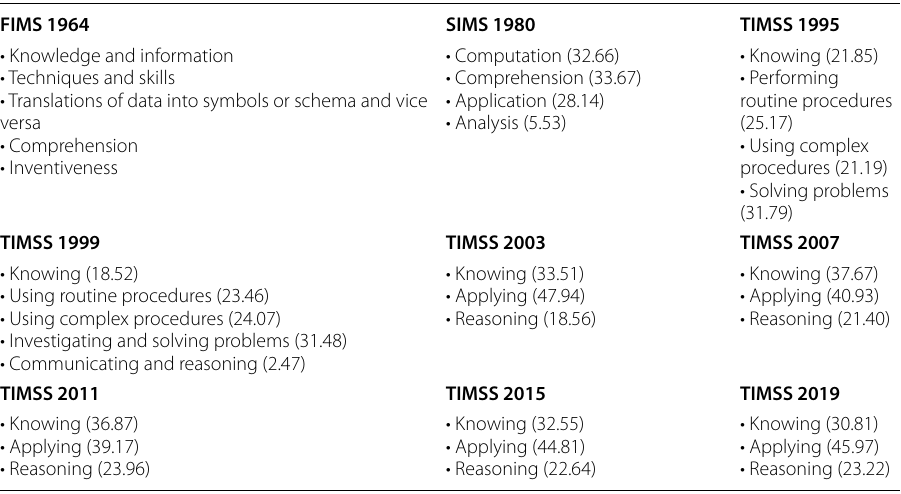
The percentage of items is shown in parentheses except for FIMS due to lack of information